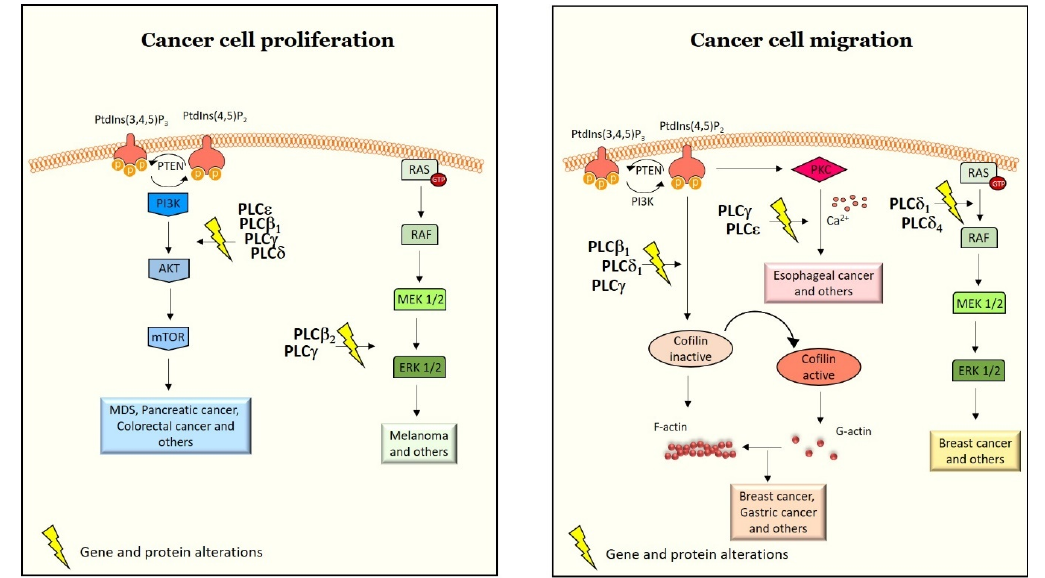
Figure 3. Cartoon representation of PLC-mediated cell proliferation and migration in different cancer types. Currently, except PLC ζ and PLC η , all other PLCs have been shown to be directly involved in the regulation of several cellular processes in cancer such as, cell proliferation and cell migration. Alterations in the expression of PLC isoforms at both genetic and protein levels in different cancer types have been shown to affect essential pathways such as the PI3K/Akt/mTOR and the RAS/RAF/MAPK/ERK pathways implicated in cancer cell survival, growth and proliferation. Similarly, these alterations also affect essential mechanisms like actin reorganization via the activation of cofilin, implicated in regulating cell migration. In addition, molecular alterations in PLC δ expression controls cell migration in breast cancer via ERK signaling. The yellow lightning symbol represents molecular alterations in gene or protein expression, that is, either upregulation or downregulation of the specified PLC isoforms.